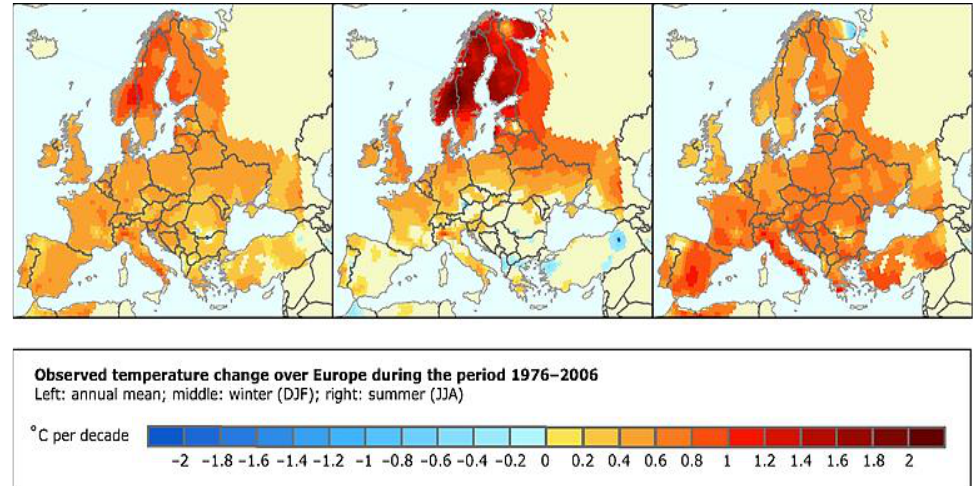
Figure 1. According to the Intergovernmental Panel on Climate Change (IPCC), since the pre-industrial period (1850–1900), the observed mean land surface air temperature has risen considerably more than the global mean surface (land and ocean) temperature.